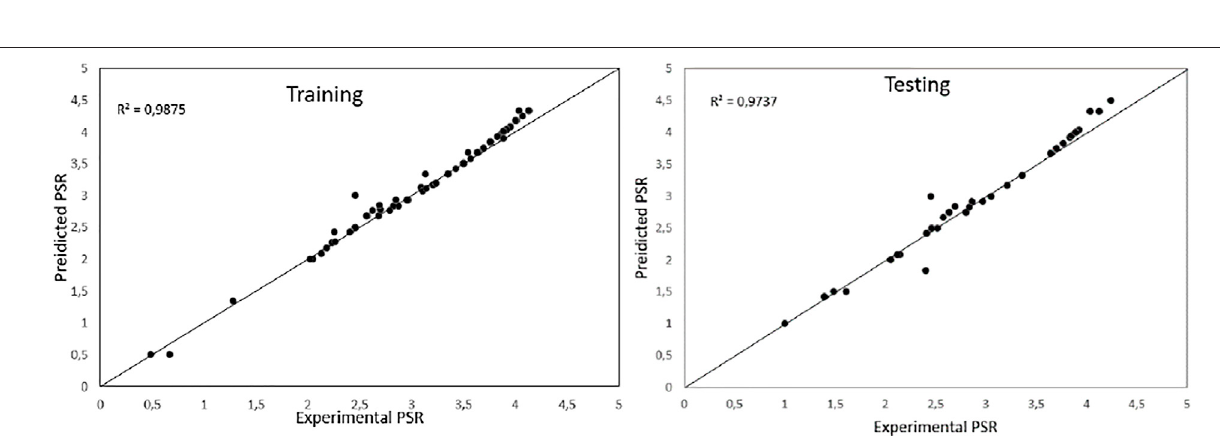
Frontiers in Built Environment |